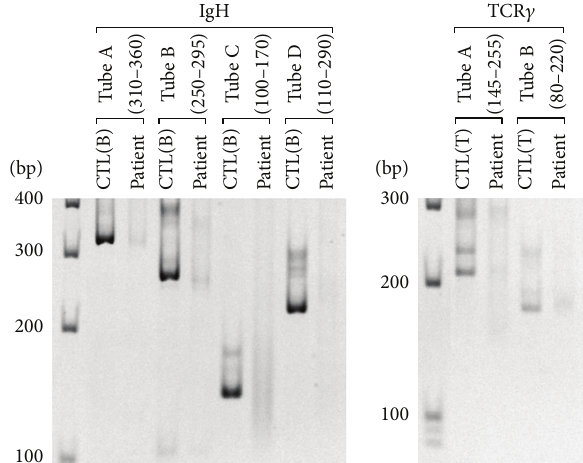
Figure 3: Results of multiplex PCR as to immunoglobulin heavy chain (IgH) and T-cell receptor gamma (TCR 𝛾 ) genes. Multiplex PCR and acrylamide gel electrophoresis were carried out according to the standardized BIOMED-2 PCR protocol. Predicted sizes of PCR products are indicated beneath the tube names. CTL(B): positive control using DNA extracted from B-cell lymphoma cells. CTL(T): positive control using DNA extracted from T-cell lymphoma cells. bp: base pair.